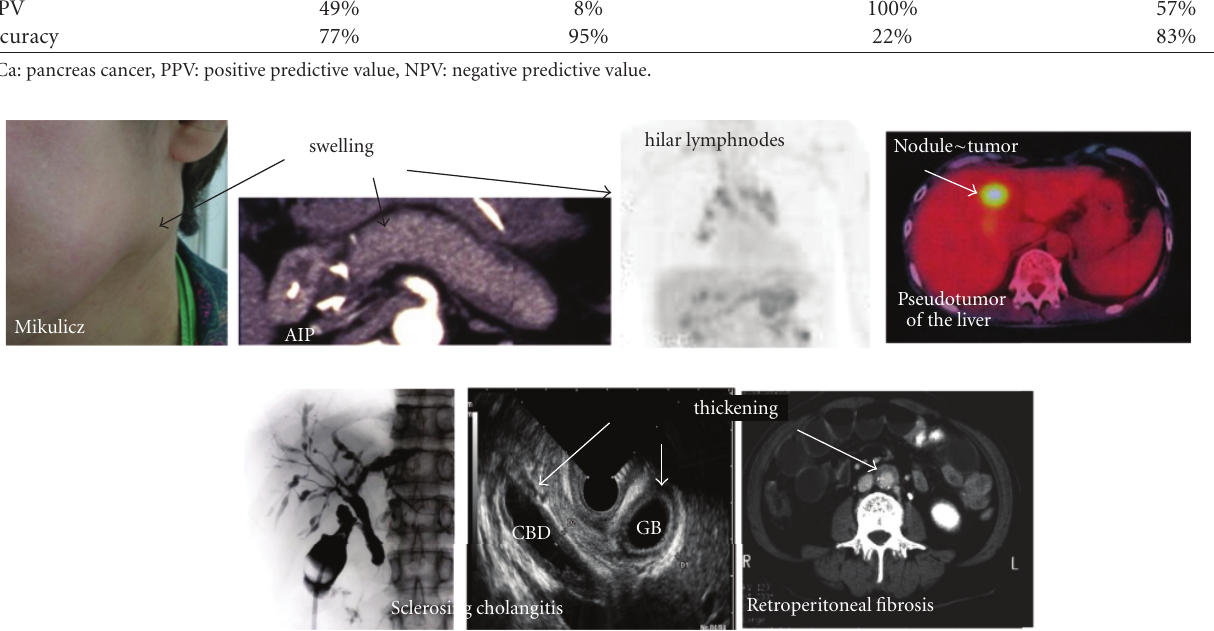
Figure 1: Clinical findings of IgG4-related disease. Physical examinations and imaging on US/CT/MRI can show the characteristic di ff use/ localized swelling, masses, or thickness in single or multiple